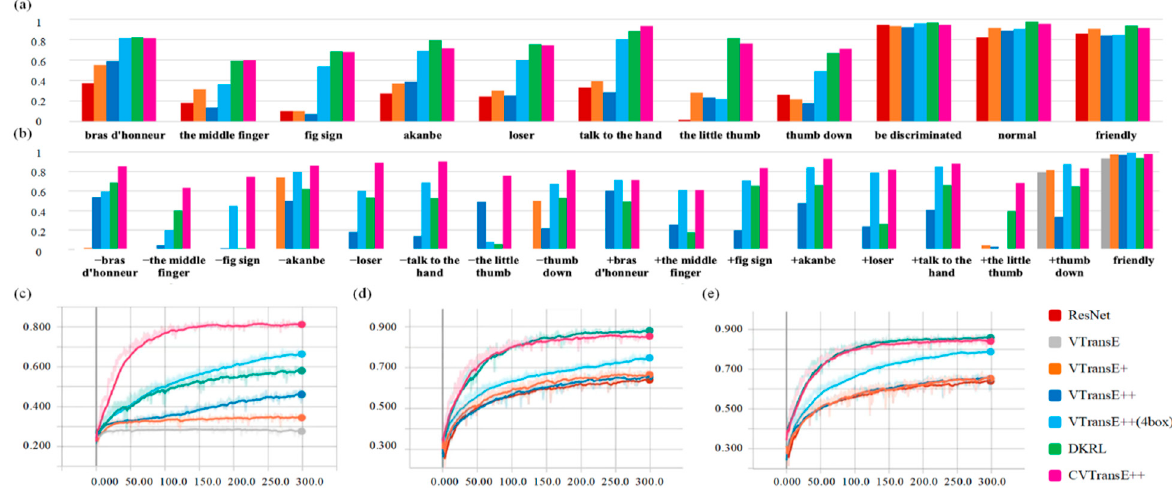
Figure 8. Accuracies of DARI. ( a ) Class accuracies of different methods on a subset of action classes. ( b ) Class accuracies of different methods on a subset of relationship classes. ( c ) Action accuracy of the subject. ( d ) Action accuracy of the object. ( e ) Relationship accuracy. Table 1. Experimental results.